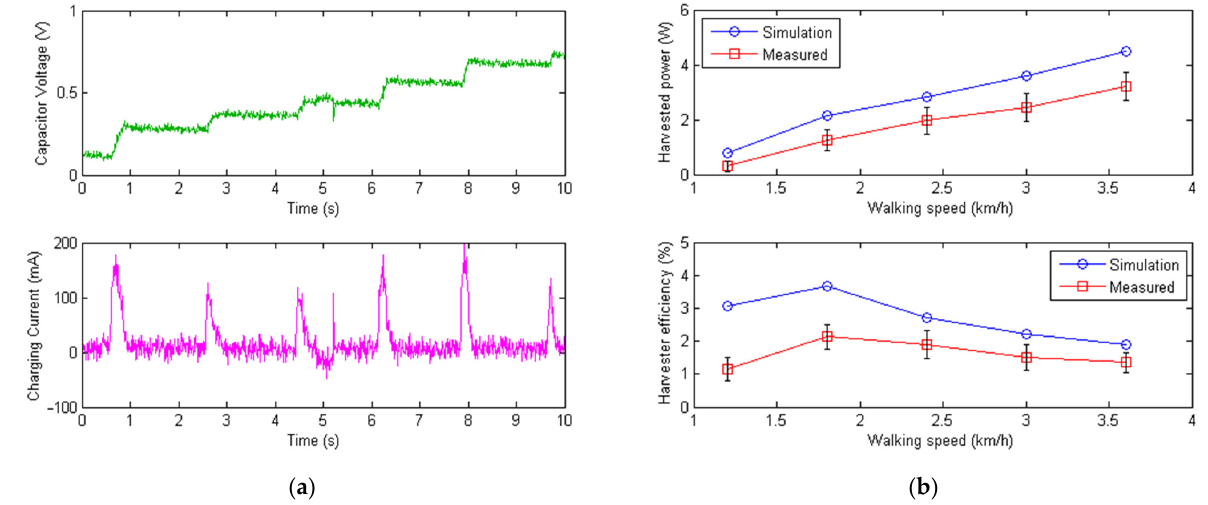
Figure 15. Plots of the measured super capacitor voltage, charging current, and harvest power with efficiency. ( a ) Time history of the measured 0.5F super capacitor voltage and the associated charging current during energy harvesting. ( b ) Simulated and measured harvested power and efficiency (with maximum and minimum shown) at different walking speeds downstairs. As the walking speed increased, the harvested power also increased.